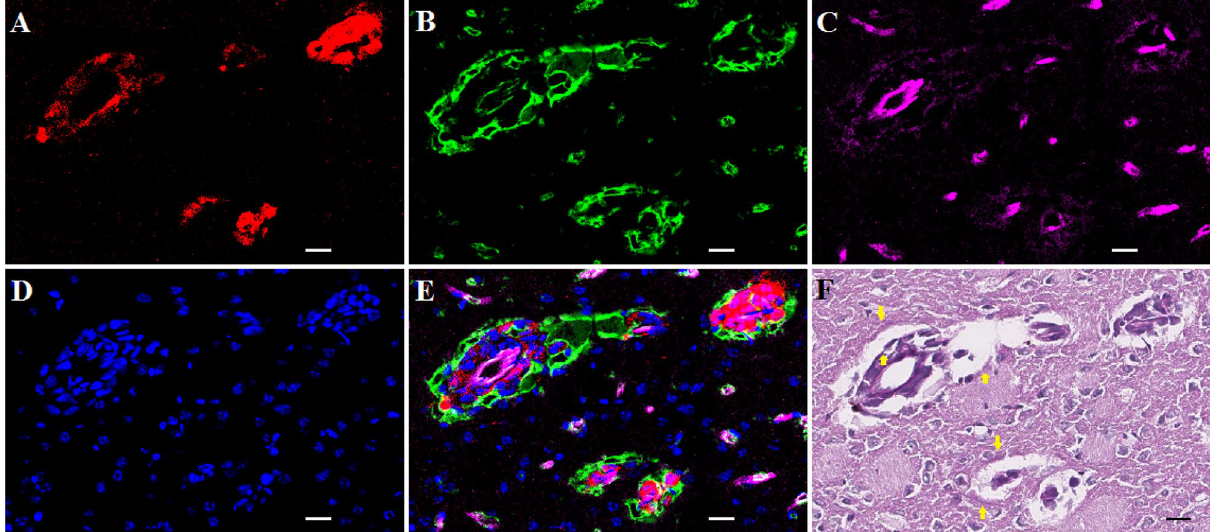
Figure 4. Migrated tumor showing ISS with INP and CD31 association. White and black bars = 10 um. A , Tumor cells (td-Tomato, red); B , INPs (antiPEG, green); C , Endothelial stain (antiCD31, violet); D , Nuclei (Dapi, Blue); E , Colors combined; F : PAS stain. Arrows in 4F: Hue of darkened PAS stain immediately outside INP and CD31 stained ISS forming around migrated tumor